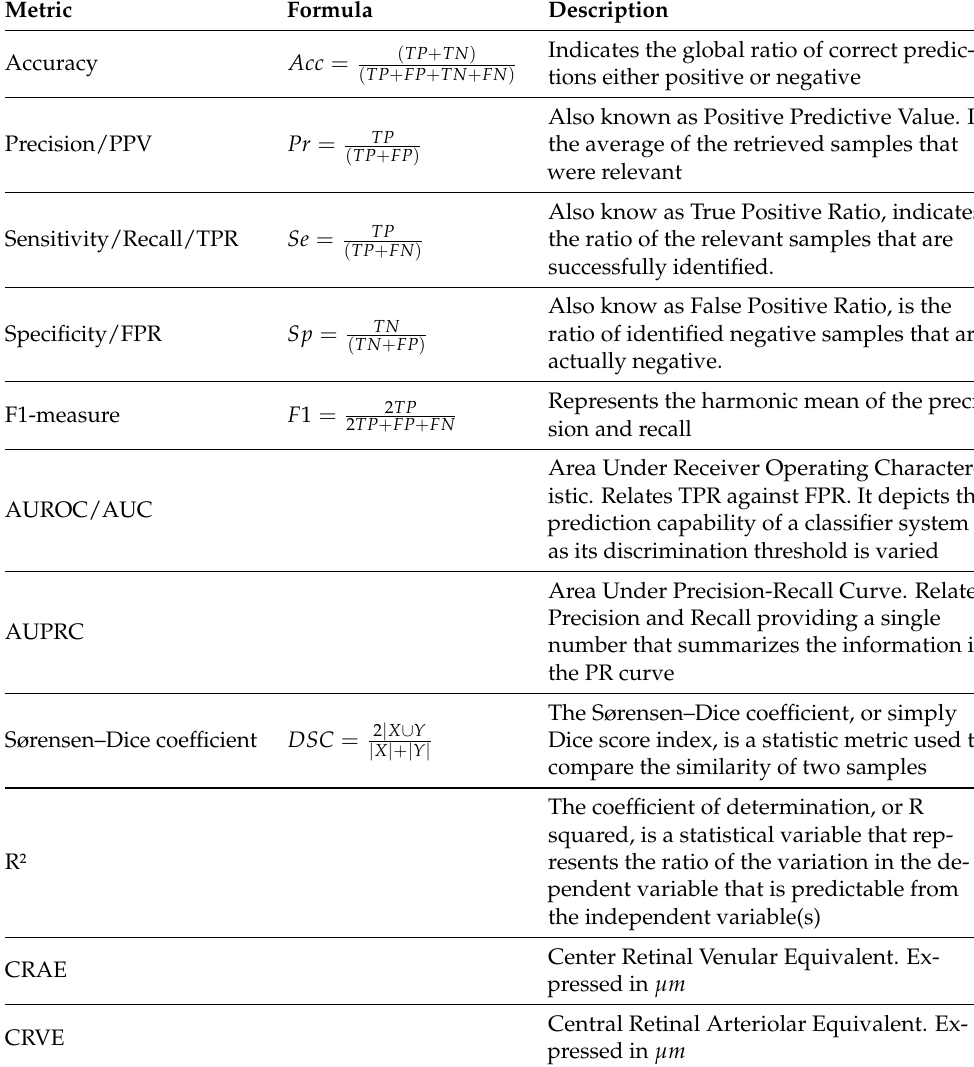
Table 2. Overview of evaluation metrics used in cardiovascular disease applications. TP stands for true positives, FP stands for false positives, FN stands for false negatives and TN for true